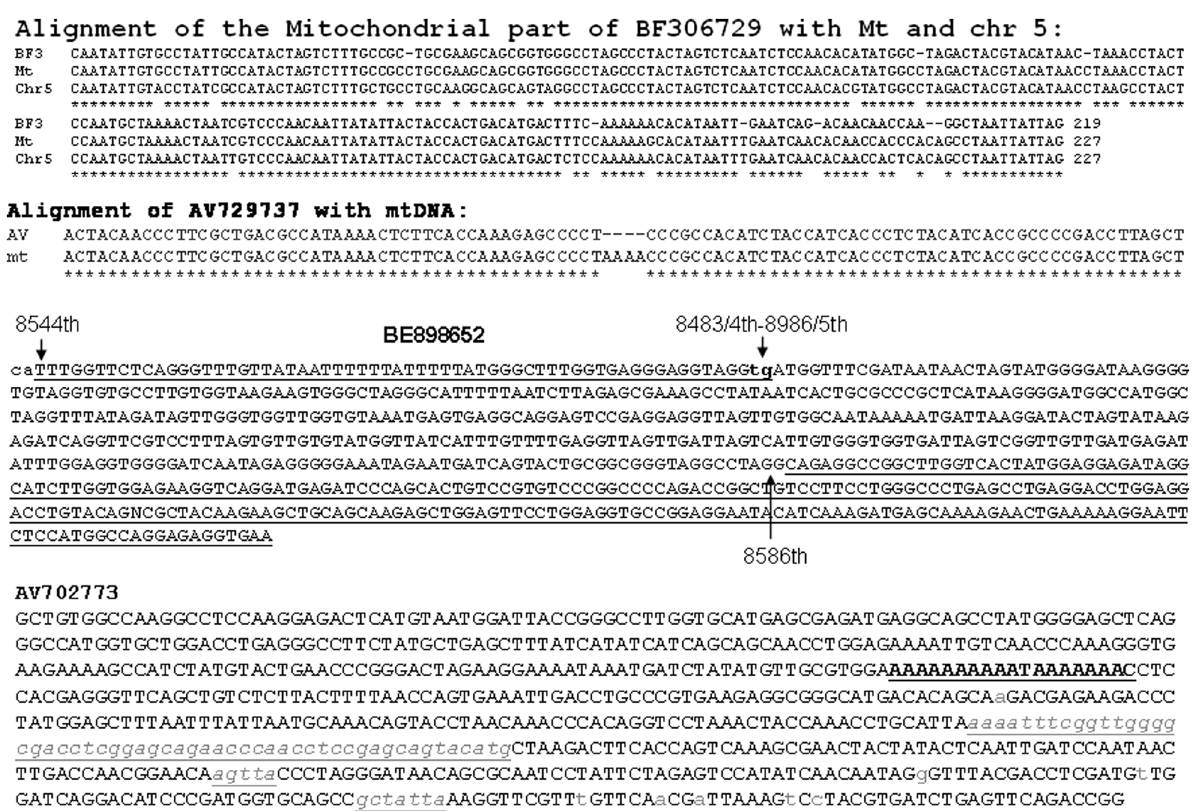
Figure 4. Cis- or trans-spiced mtRNA in ESTs. Alignment of the mt-part of EST BF306729 (BF3) with mtDNA (mt) and a corresponding NUMT on chromosome 5 (Chr 5) shows that the EST matches better to the mtDNA than to the NUMT, suggesting that the mt-sequence is more likely to be transcribed from mtDNA, but not its nuclear counterpart. Mismatched positions are often deletions. AV729737 is an mt-only EST that has an ‘‘AAAA’’ deletion when aligned with mtDNA. BE898652 is a trimera containing trans-spliced mt-sequence. Its 3–64th nt region is matched to the L-strand of an mtDNA (AC_000021), which is part of the ATP8 gene’s antisense, while its 63–461st nt sequence is matched to the 8586–8986th nt of the L-strand, which is part of the ATP6 gene’s antisense. The two sequences overlap at the boldfaced lowercase ‘‘tg’’. The last part of this EST (underlined) is part of the PSMC4 mRNA from chromosome 19. AV702773 is a chimera. Its 1–245th nt region belongs to the last 3 exons of the PSME2 mRNA from chromosome 14, which is followed first by a poly-A signal (the 246–263rd nt, containing a T) and then by an mt-sequence (265–708th nt) from the 16S rRNA gene (the 2639–3082nd nt of mtDNA). However, since the PSME2 mRNA (NM_002818.2) in the NCBI database does not have a poly-A signal or a poly-A tail, it is unclear whether this poly-A is part of PSME2 that is undocumented or is part of the following mtRNA that is polyadenylated. Note that one long and two short italicized lowercase sequences in grey within the mtDNA region do not actually exist in, i.e. are deleted from, AV702773. Several single lowercase letters in grey are mismatches to the mtDNA (AY195786.2).